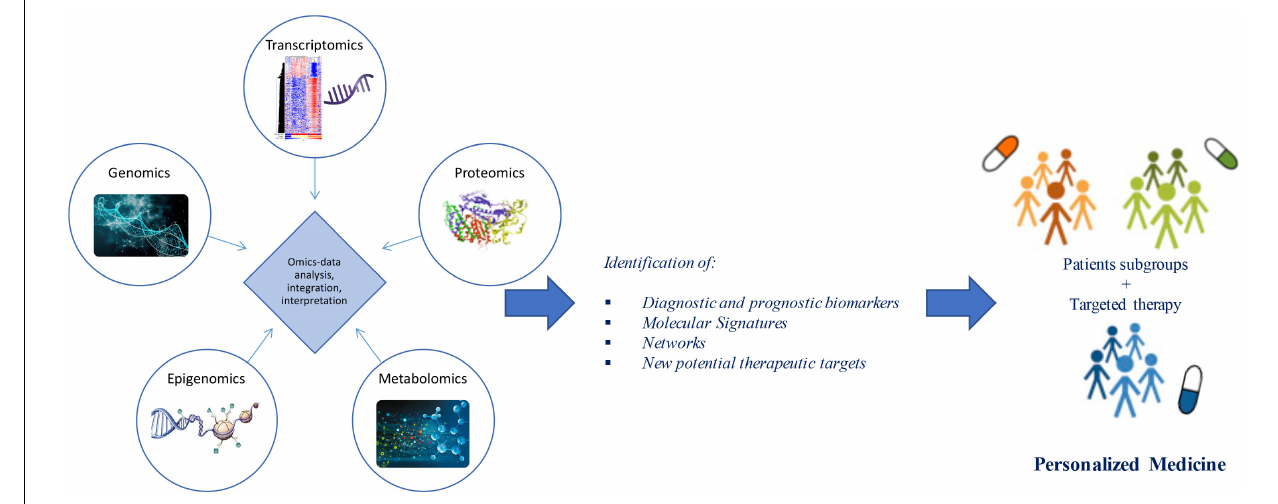
FIGURE 1 | From omics technology to precision medicine in ALS. Multi-omics (e.g., genomics, transcriptomics, proteomics, epigenomics, metabolomics) data analysis and integration may allow patient stratification and targeted therapies. Through a “systems biology” approach, these technologies may move medicine from a “one-size-fits-all” toward a “personalized”